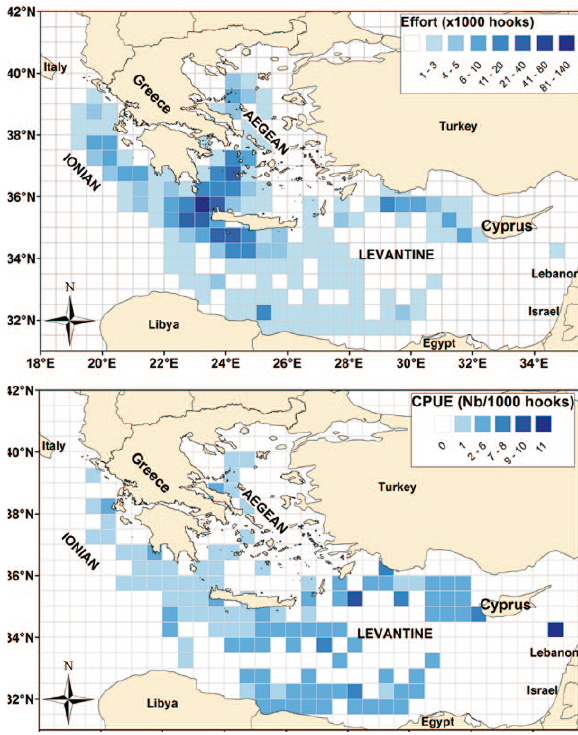
Fig . 1. – Map of the study area with spatial distribution of fishing effort (top) and nominal catch per unit of effort (bottom) in 1998– 2005 in the eastern Mediterranean Sea. (Note: spatial resolution of fishing effort is 1/2 a degree; values refer to the whole study period and not individual fishing sets; Nb: number)